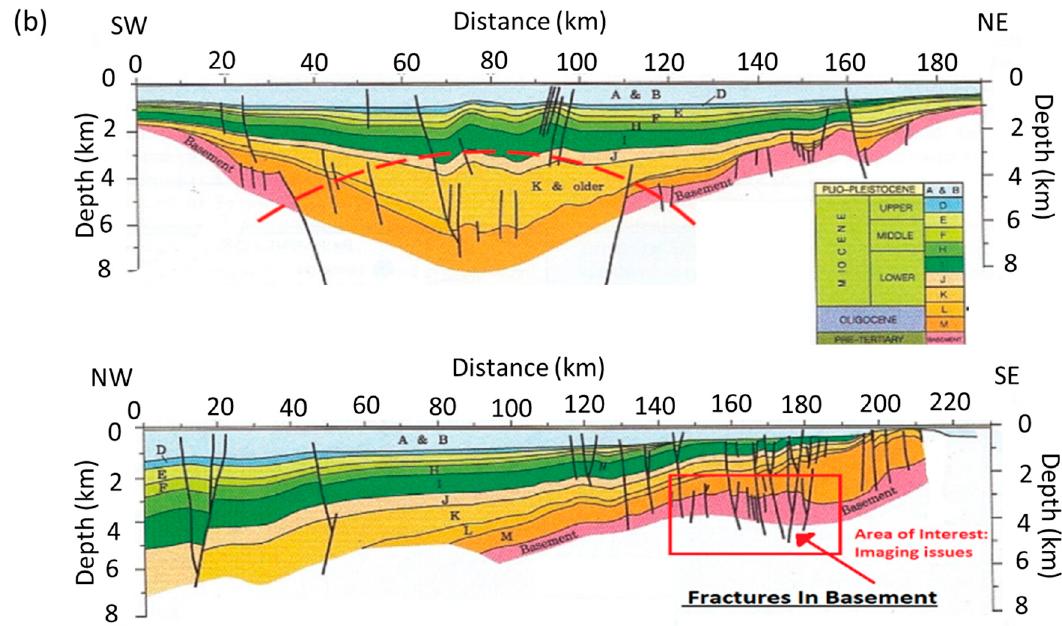
Figure 1. ( a ) Geographical location of the Malaysian Basin and ( b ) Malay Basin subsurface structure with a cross-section view. The fractured basement can be seen at a depth of 2–5 km, varying with lateral extension [9].